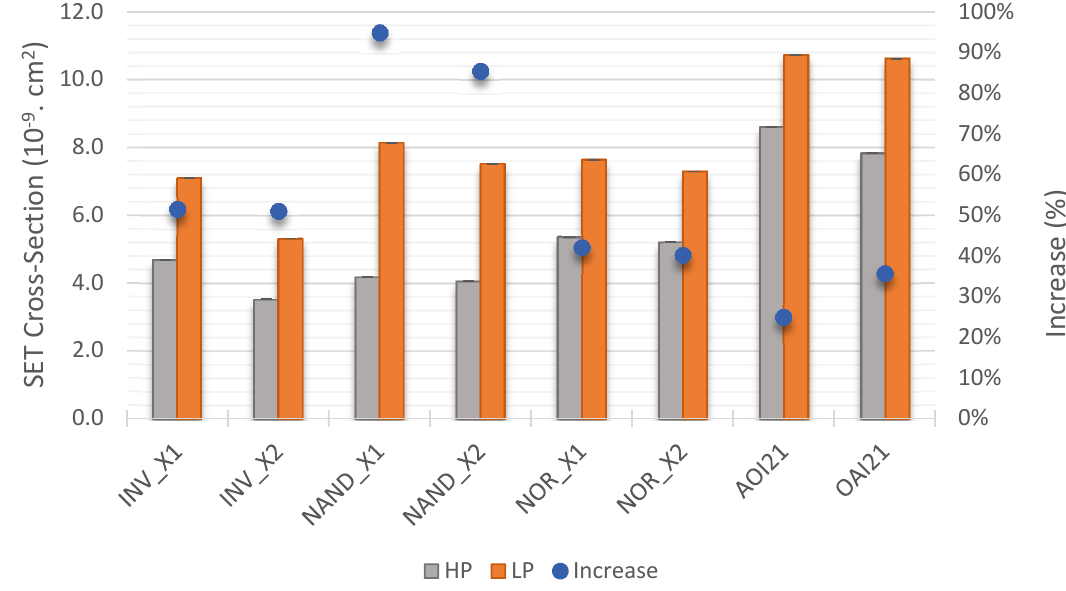
Figure 5. Impact of different threshold voltage devices (High ‐ Performance vs. Low ‐ Power devices).